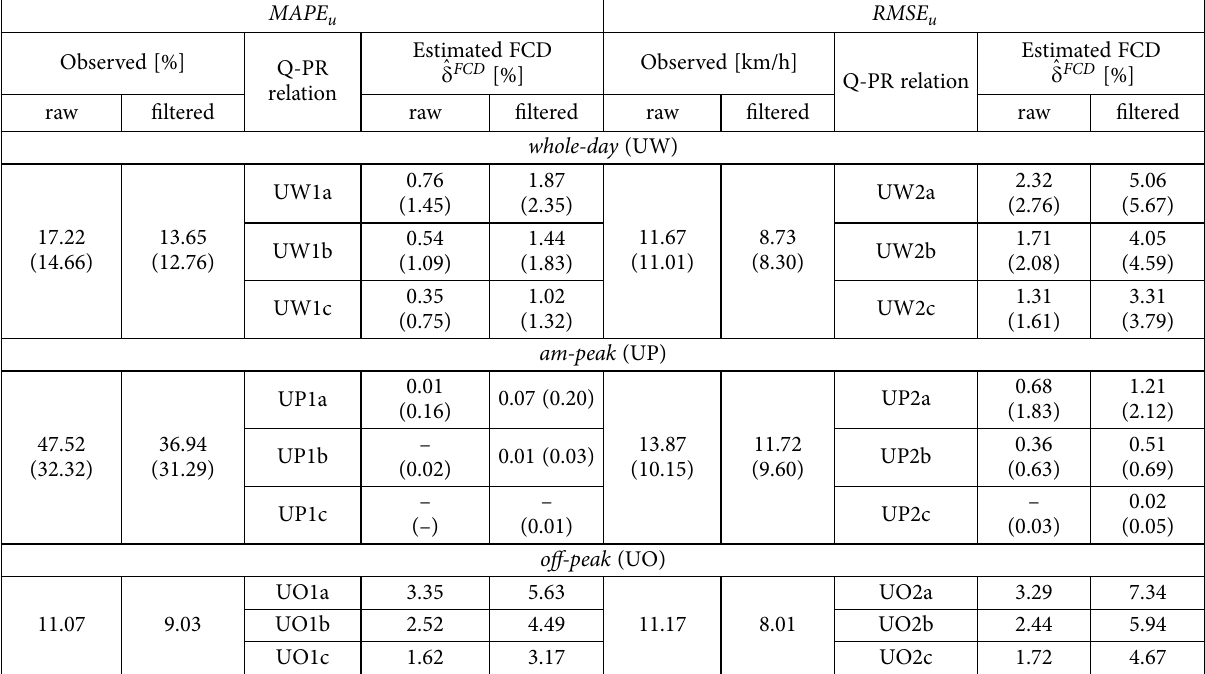
Table 5. Estimated traffic PR of commercial FCD-based on Q-PR